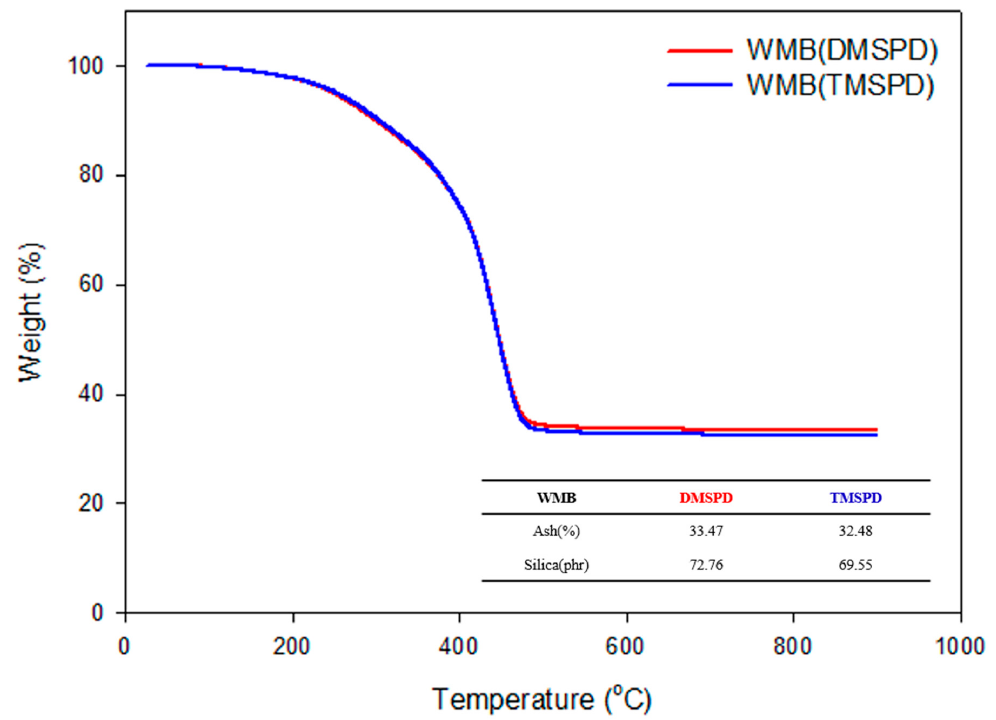
Figure 6. The evaluation of remaining silica content in the wet masterbatch (WMB) sample with methoxy-type SCAs.